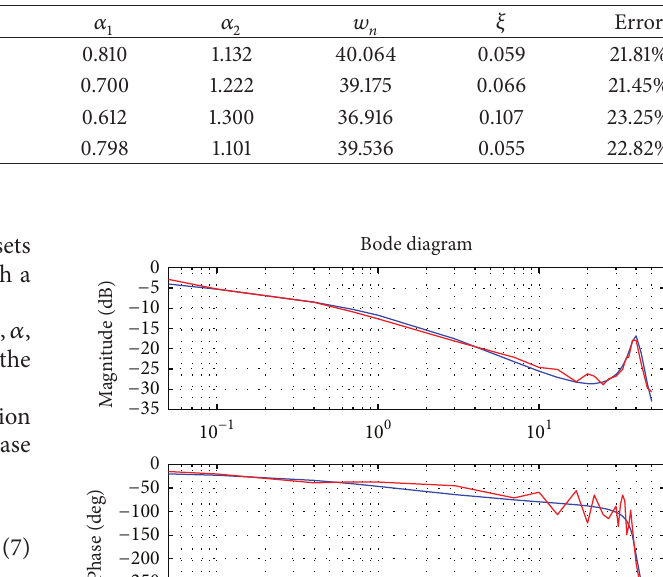
Table 2: FOTF parameters simplex optimized.